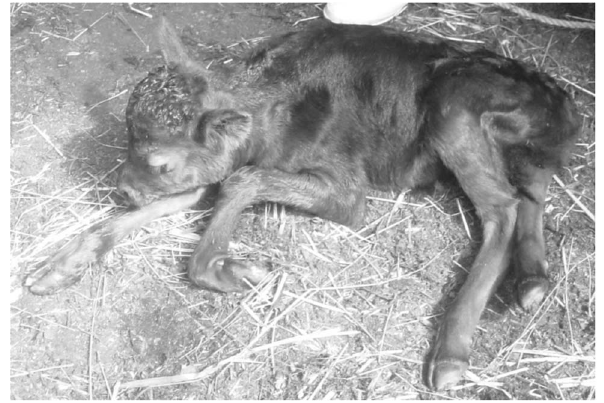
Figure 1. A calf with perinatal weak calf syndrome. The birth weight was 16 kg (normal average; 28.4 6 4.24 kg). The gestation period was 296 days (normal average; 288.9 days). The affected calf was weak and had difficulty nursing. The calf died at 2 days